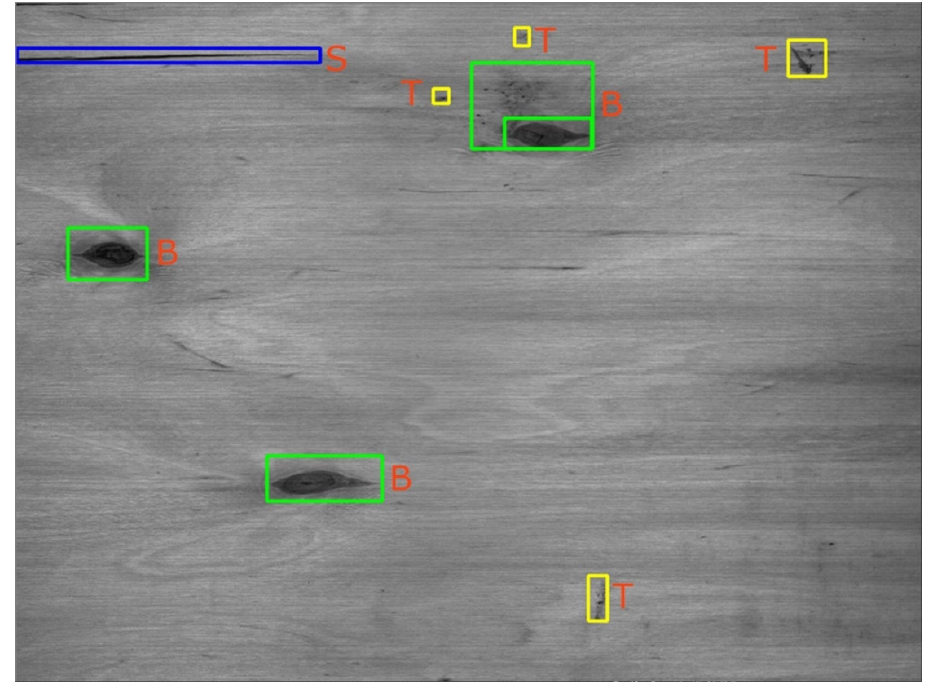
Figure 5. An image of wood veneer labeled using VoTT. Green is used to label the branch (B) defects. Blue is used to label the split (S) defects. Yellow is used to label the stain (T)